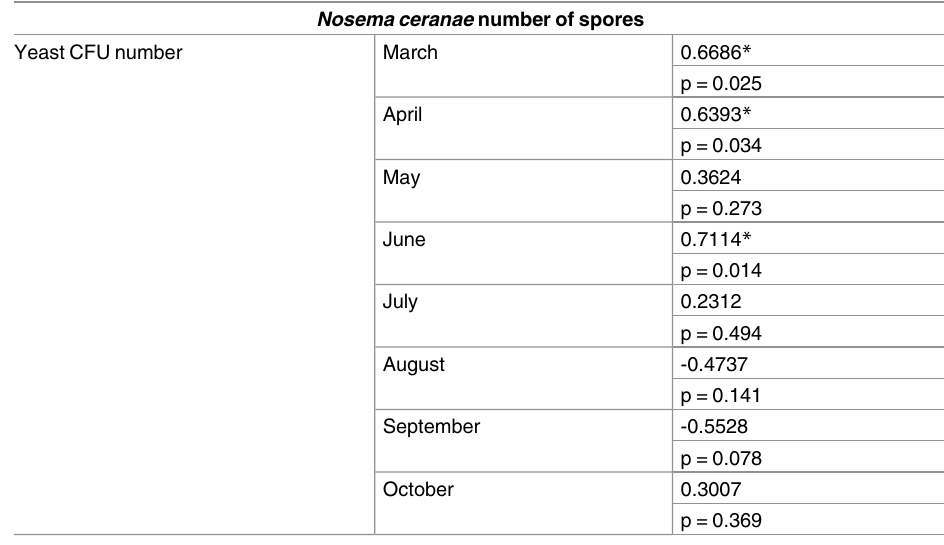
Table 2. Field tests. Spearman’s correlationcoefficients between yeast CFU and N . ceranae number of spores. Significantcorrelations(p < 0.05) are indicatedwith an